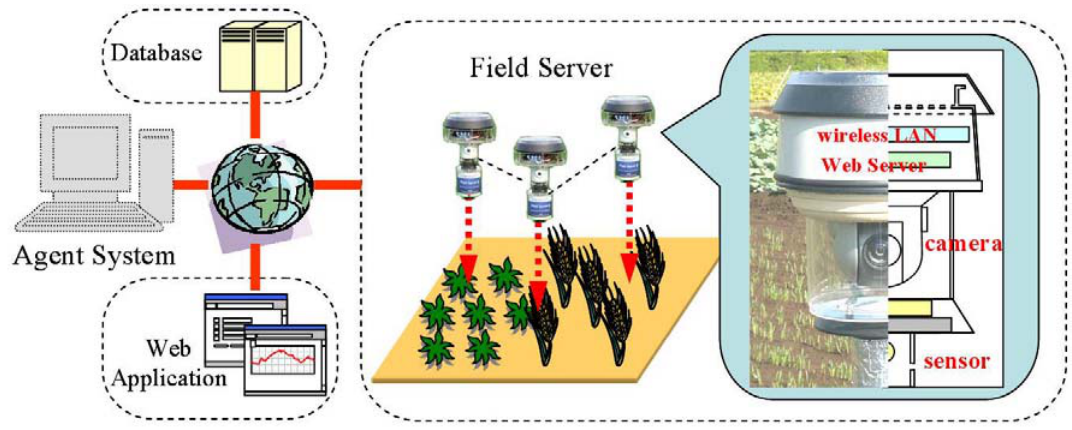
Figure 2. System architecture of Field